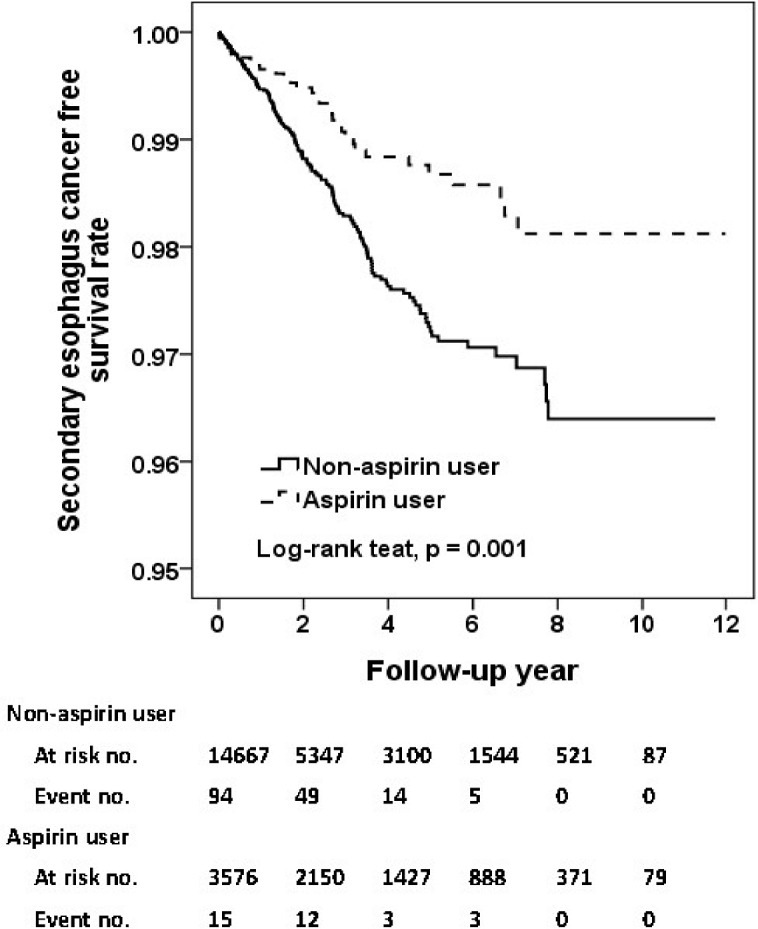
Secondary esophagus cancer free survival rates for primary HNSCC cohort with and without aspirin intake.